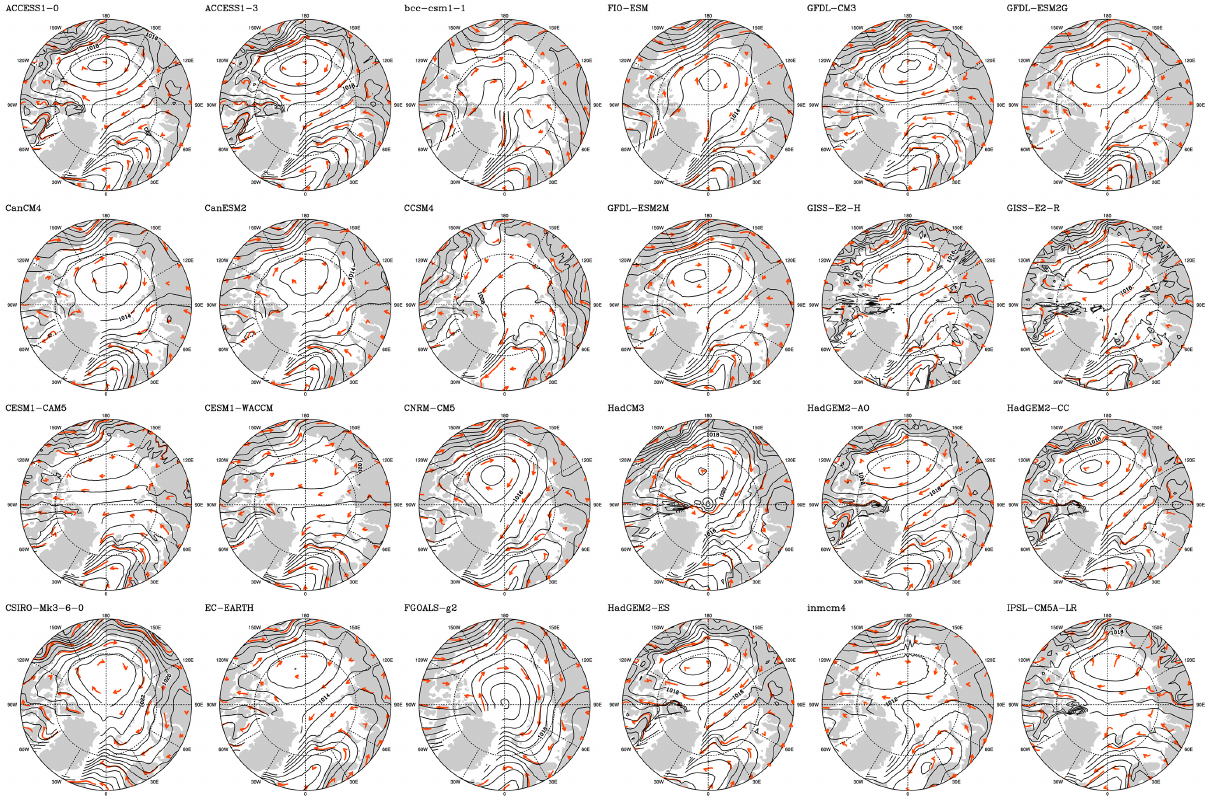
Figure 6. Mean annual sea level pressure and geostrophic wind from 27 CMIP5 models and from ERA-Interim spanning 1981–2010. Con- tour interval is 1hPa. Near-surface geostrophic wind is used as a proxy for sea ice motion and is shown by red vectors. Vector length is proportional to wind speed. Vectors are curved tangents to the instantaneous